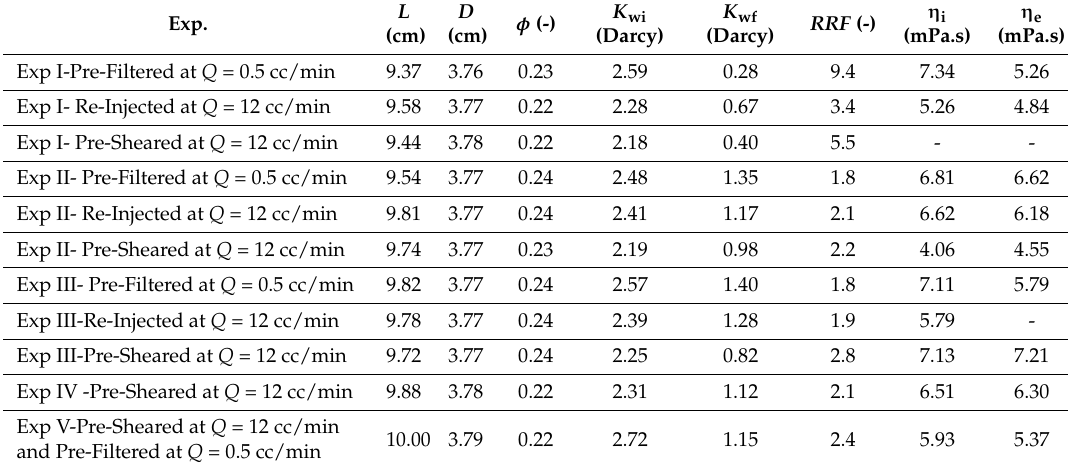
Table 6. Core and solution properties for reproducibility study performed with Solution A (Concentration = 500 ppm, MW = 18 MDa).